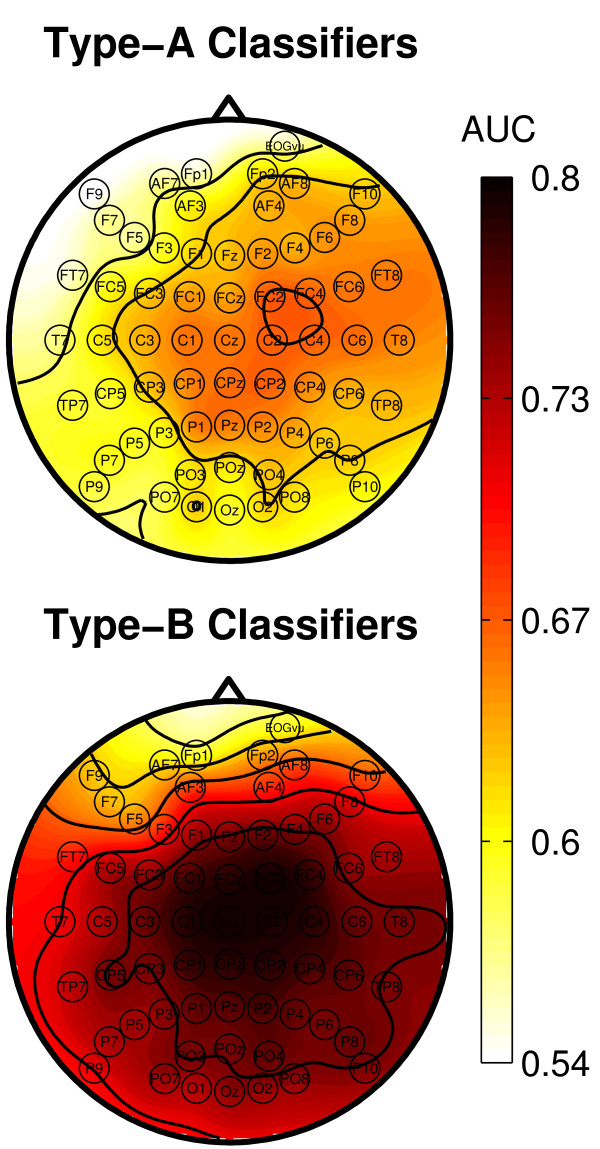
Spatial Classification. Spatial distribution of the AUC scores for ErrP classifiers of type-A (top) and type-B (bottom) shown as scalp topography. Classification was performed for each channel separately. Peak performance was reached at central regions for both types (A:0.67, B: 0.8), frontal regions are near chance level. The performance is higher for type-B than for type-A classifiers in all regions.